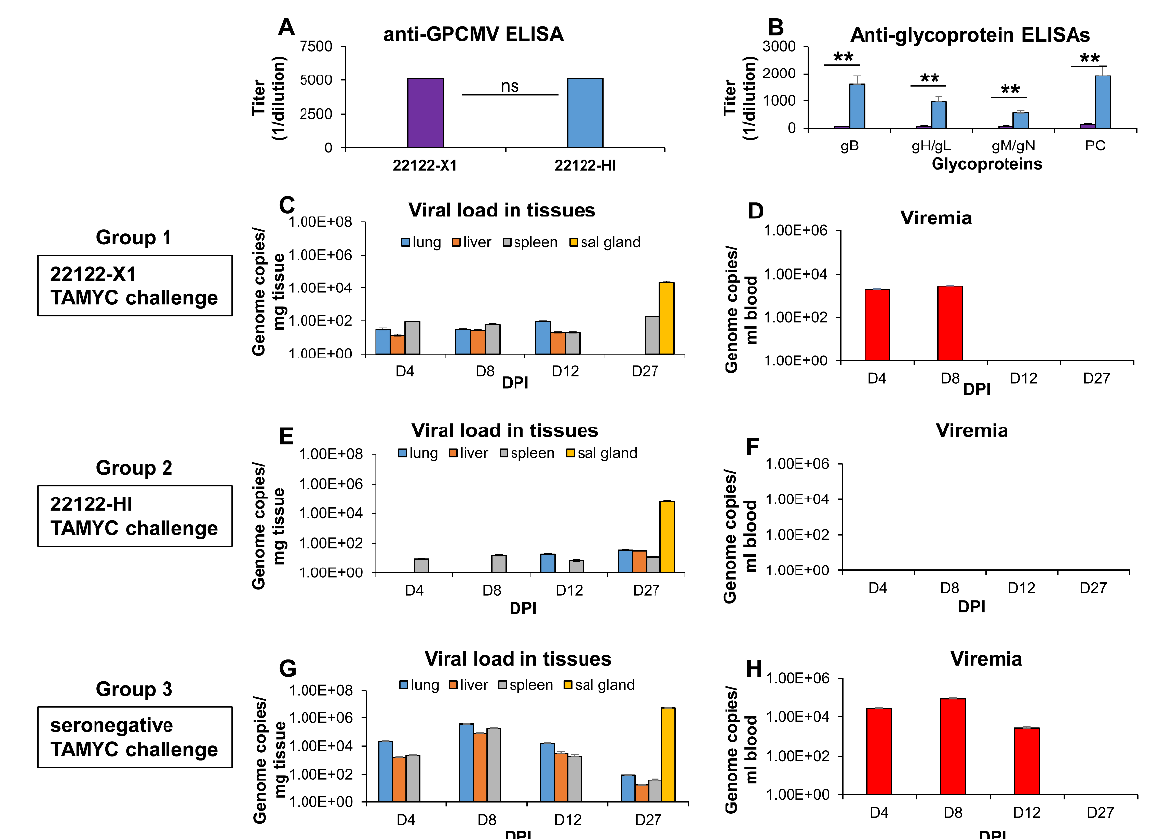
Figure 3. Comparative heterologous GPCMV (TAMYC strain) dissemination in convalescent (22122 strain) or control seronegative animals. Animals were infected with GPCMV (22122 strain) by single injection to establish convalescent natural immunity (22122-X1) or 3 sequential injections to establish hyperimmune status (22122-HI) prior to challenge (1 x 10 5 pfu, SQ) with GPCMV (TAMYC strain). Convalescent animals were evaluated for anti-GPCMV ELISA titer and specific anti-glycoprotein ELISA titers. ( A ) Mean anti-GPCMV ELISA titer comparison of sera from animals in 22122-X1 group (purple) or 22122-HI group (blue). ( B ) Comparative mean anti-glycoprotein complex ELISA titers (gB, gH/gL, gM/gN, PC) from sera of animals in 22122-X1 (purple) or 22122-HI group (blue). Statis- tical analysis determined by unpaired Student’s t test; ** p < 0.005; ns = non-significant. ( C – H ) Com- parative GPCMV (TAMYC strain) dissemination in convalescent animals: ( C , D ) group 1 (22122-X1); ( E , F ) group 2 hyperimmune (22122-HI); or ( G , H ) group 3 control seronegative animals. Animals (n = 12/group) were injected with 1 x 10 5 pfu, SQ of GPCMV (TAMYC strain). On days 4, 8, 12 and 27 post infection (dpi), 3 animals from each group were evaluated for viral load in target organs (lung, liver and spleen), by real-time PCR of DNA extracted from tissue. Viral load plotted as viral genome copies/mg tissue. Salivary gland (sal gland) tissue was only evaluated at 27 dpi ( C , E , G ). Viremia detected at 4, 8, 12 and 27 dpi was plotted as genome copies/mL blood ( D , F , H ).